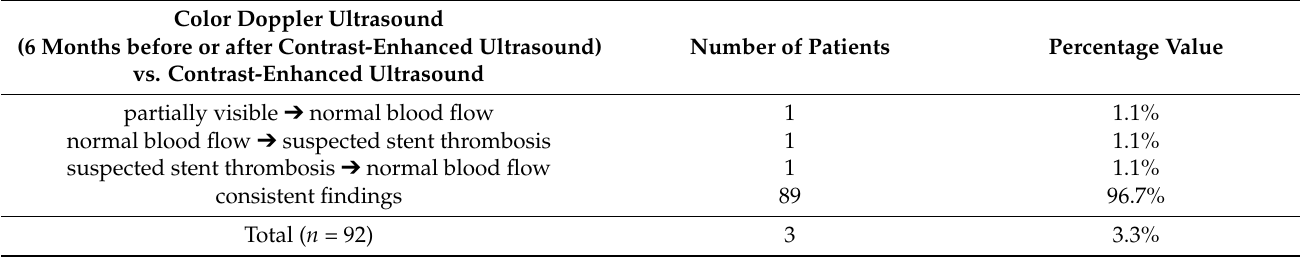
Table 4. Depiction of the different findings during Color Doppler ultrasound (6 months before or after contrast-enhanced ultrasaound (CEUS)) and CEUS.